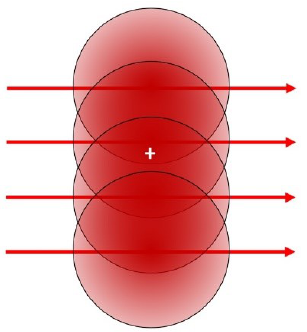
Figure 17: Schematic illustration of the multiple interactions of the laser beam (indicated by the red circles) on a given point (white cross) which leads to heat accumulation between passes